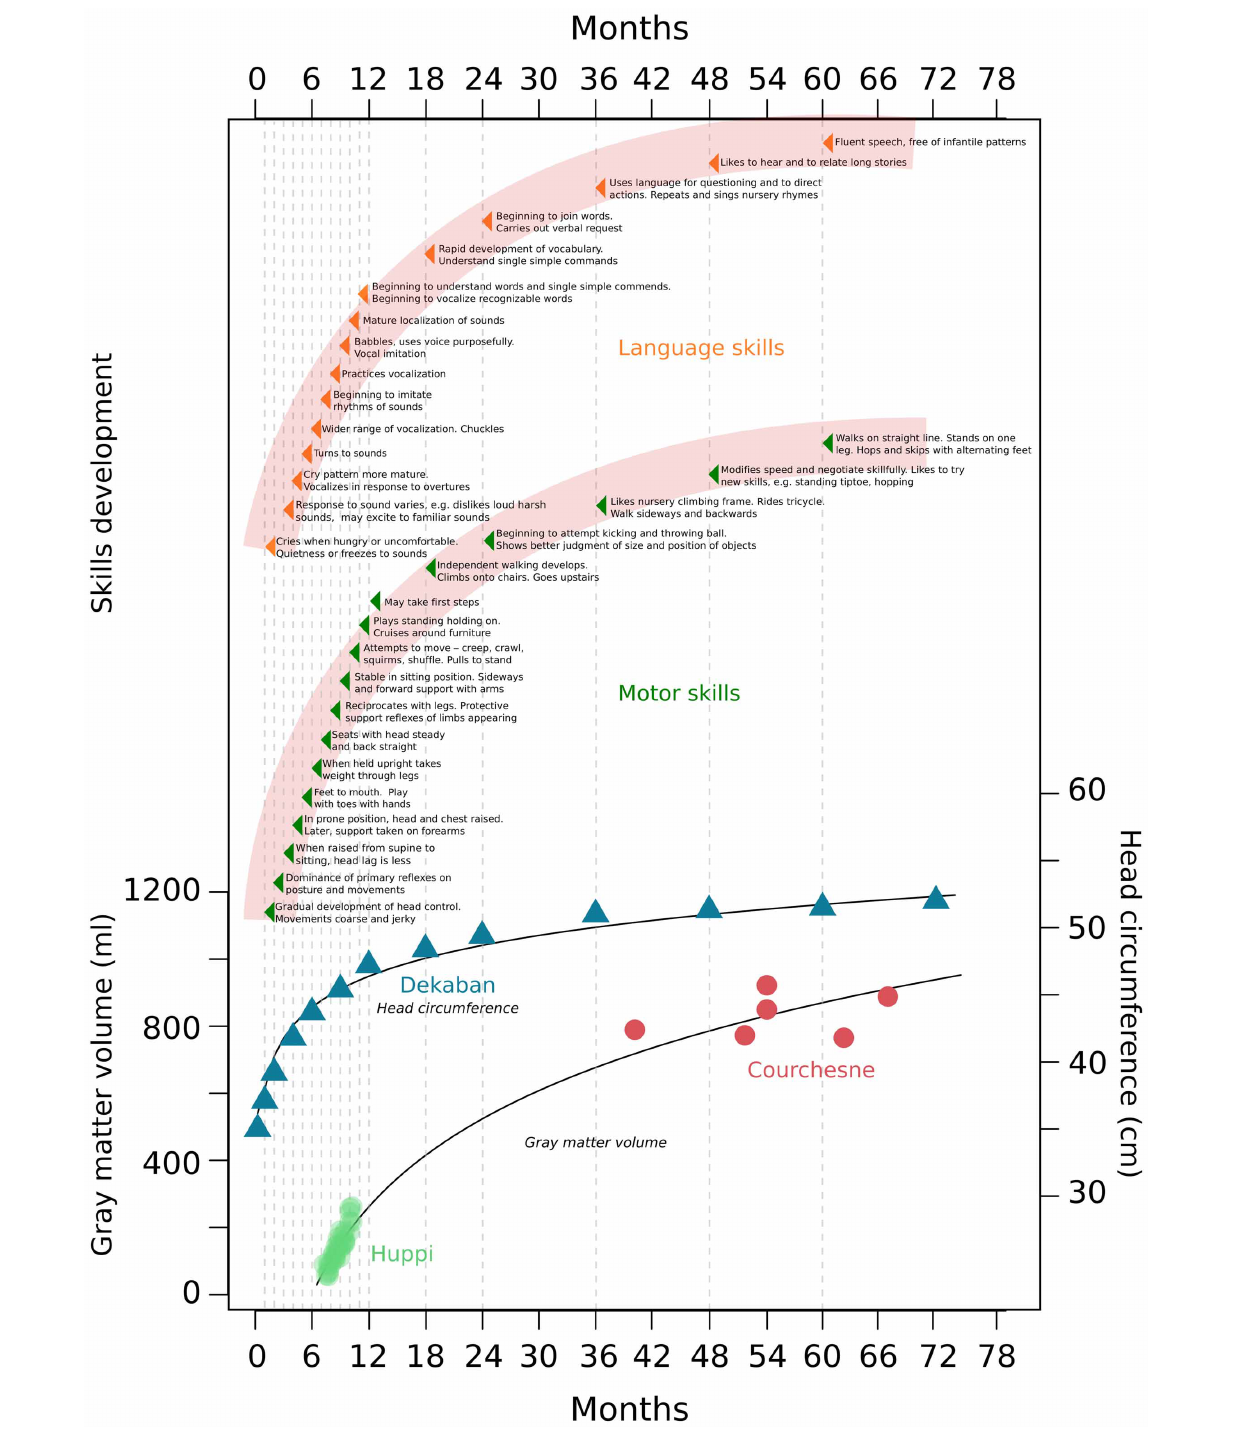
FIGURE 1 | Gray matter, head circumference, and skills development during the first years of human life. This figure combines data from different studies measuring gray matter and head circumference increases,